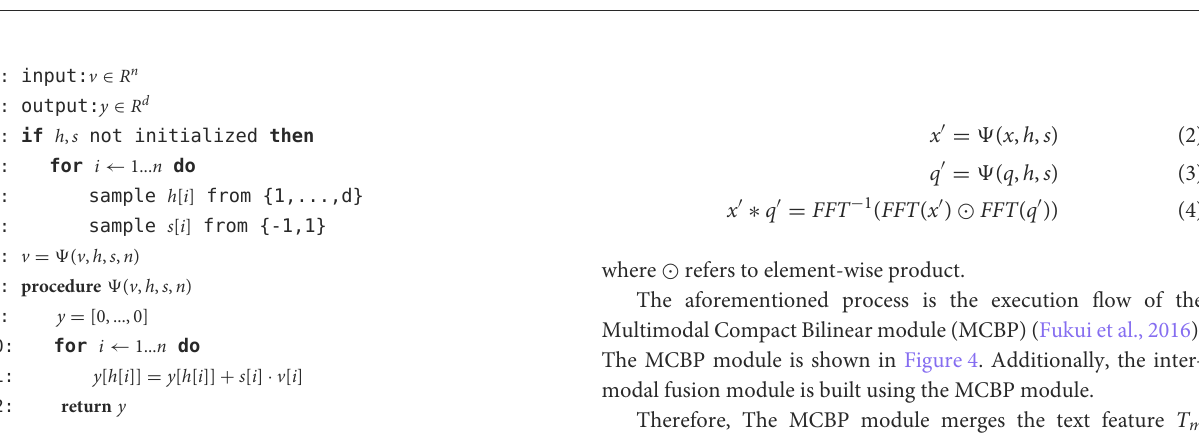
Algorithm 1. Count